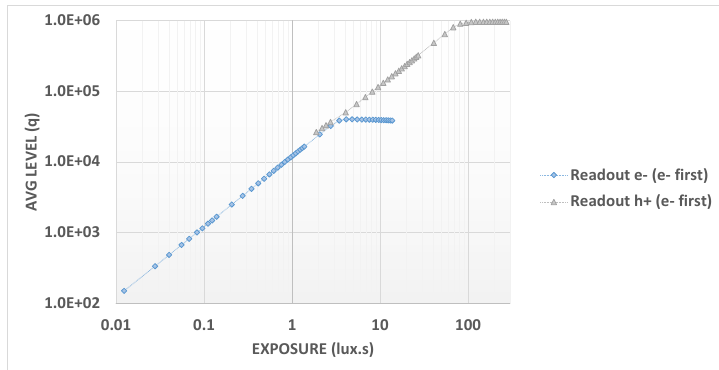
Figure 9. Linearity versus exposure.